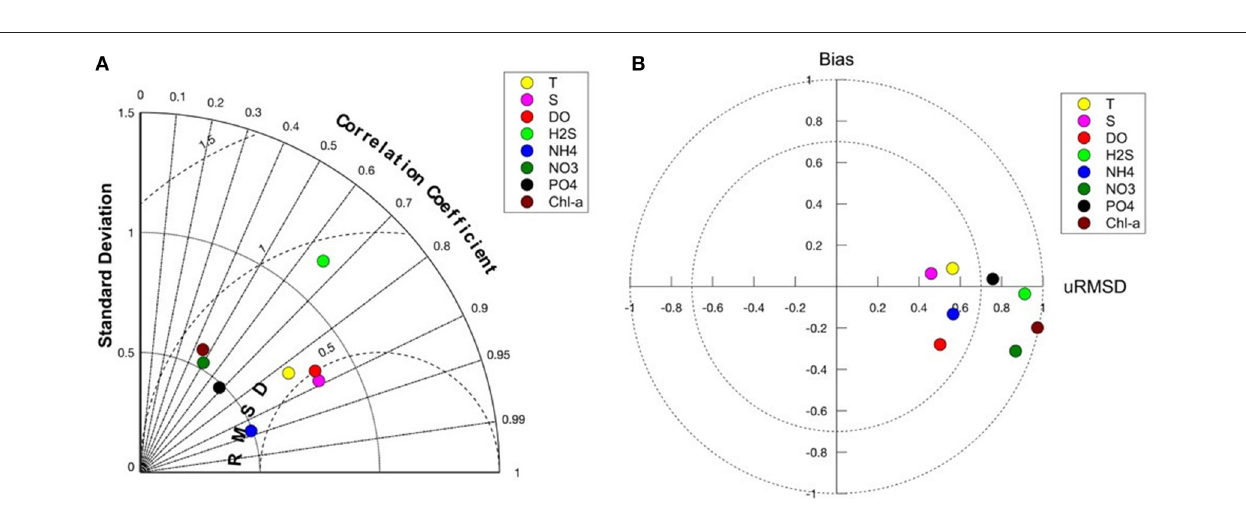
FIGURE 5 | (A) Taylor diagram showing model-data comparison of the lower trophic level model hindcast simulation with data obtained from the Black Sea data base (http://sfp1.ims.metu.edu.tr). The angle describes the correlation between model and data, the distance from the origin is the normalized standard deviation and the dashed circles around reference point (1) on the x-axis defines the root mean squared error. (B) Target diagram of model-data comparison. The y-axis corresponds to the normalized bias, the x-axis corresponds to the unbiased RMSD (root mean square